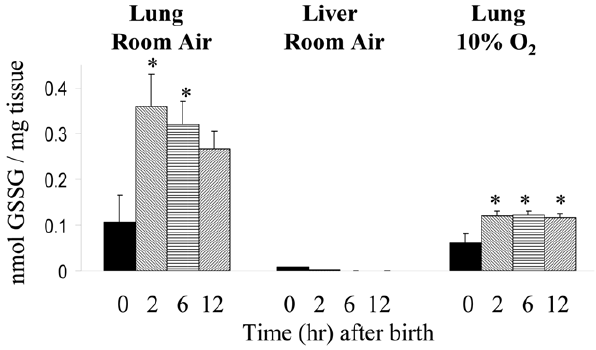
Figure 6. Glutathione disulfide accumulation at birth. Glutathi- one disulfide (GSSG) was measured in the lung and the liver of mice just before birth (time 0) and then 2 h, 6 h and 12 h after birth in room air and at similar times in the lungs of mice born in 10% oxygen. Asterisks denote p , 0.05 compared to value at time 0.